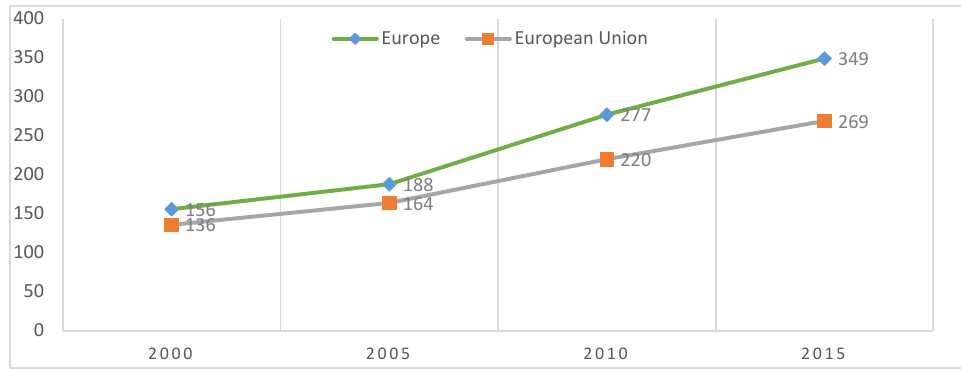
Figure 3. Development of organic producers 2000–2015 (in thousands of producers). Source: FiBL-AMI survey 2006–2017 based on national data sources and Eurostat.